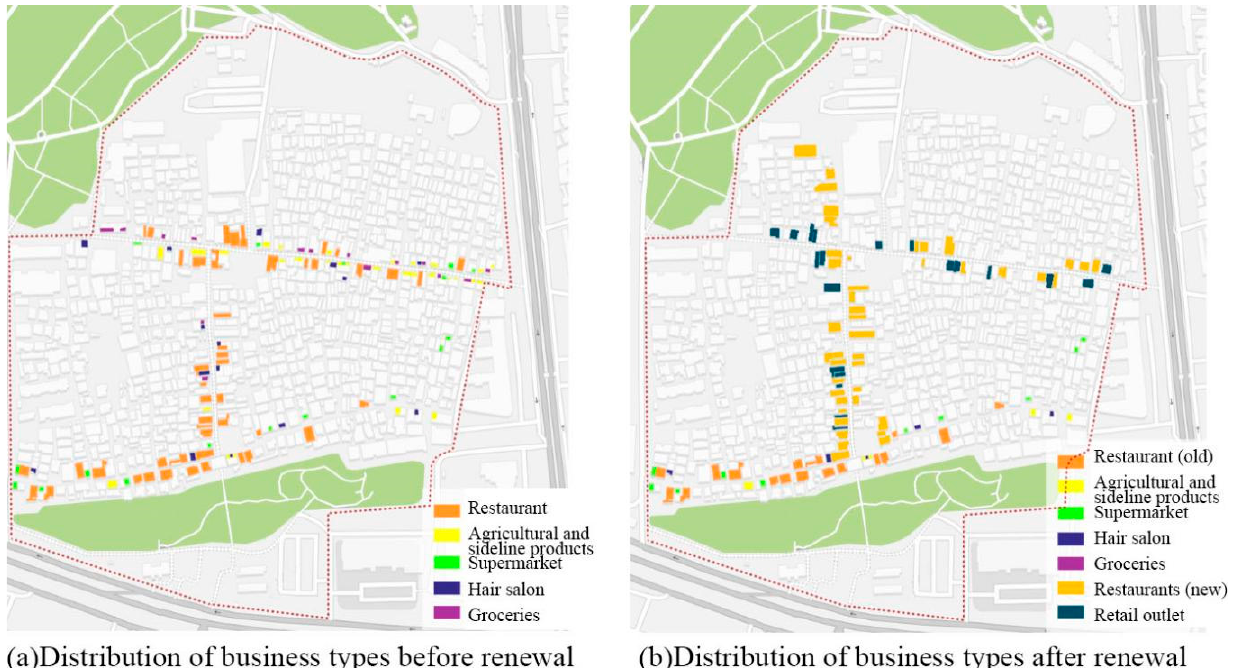
Figure 8. Comparison of business types before and after the renewal of Nantou Ancient City (Redrawn based on reference [44]).